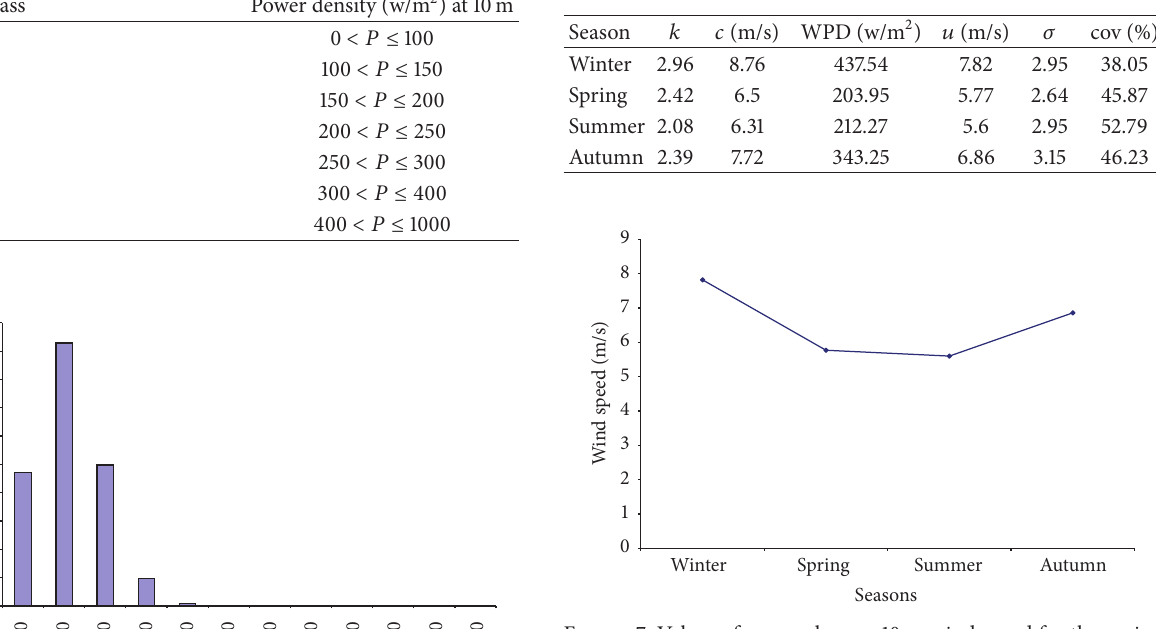
Figure 7: Values of seasonal mean 10 m wind speed for the period 1980–2009 in the ECS, unit: m/s.